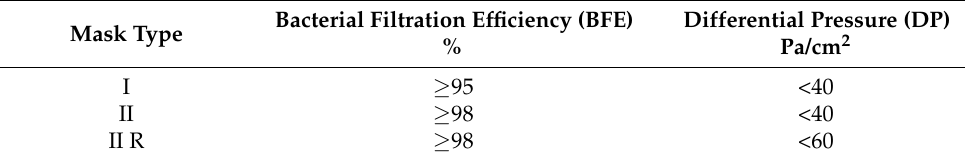
Table 1. Performance requirements for medical face masks for bacterial filtration efficiency (BFE) and differential pressure (DP) according to the standard EN 14683:2019+AC “ Medical face masks— Requirements and test methods ”